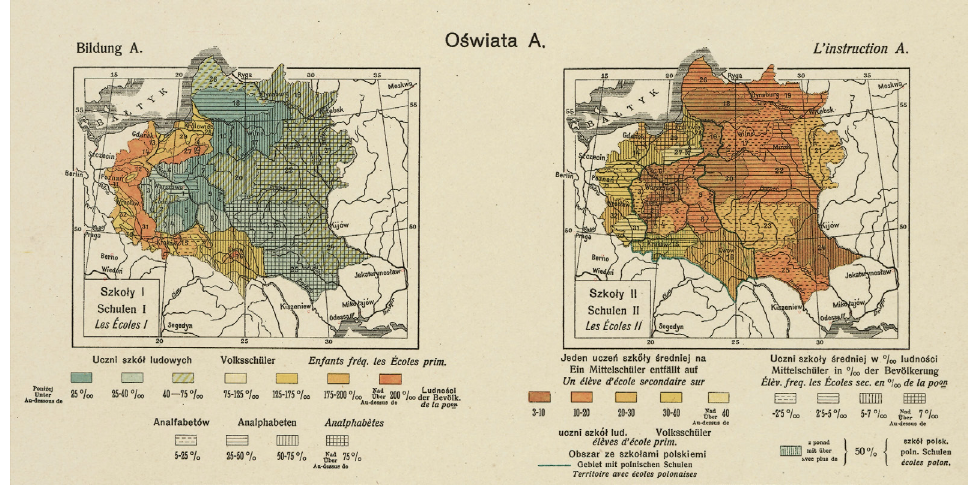
Fig. 5. Table XV. Oświata A (Education